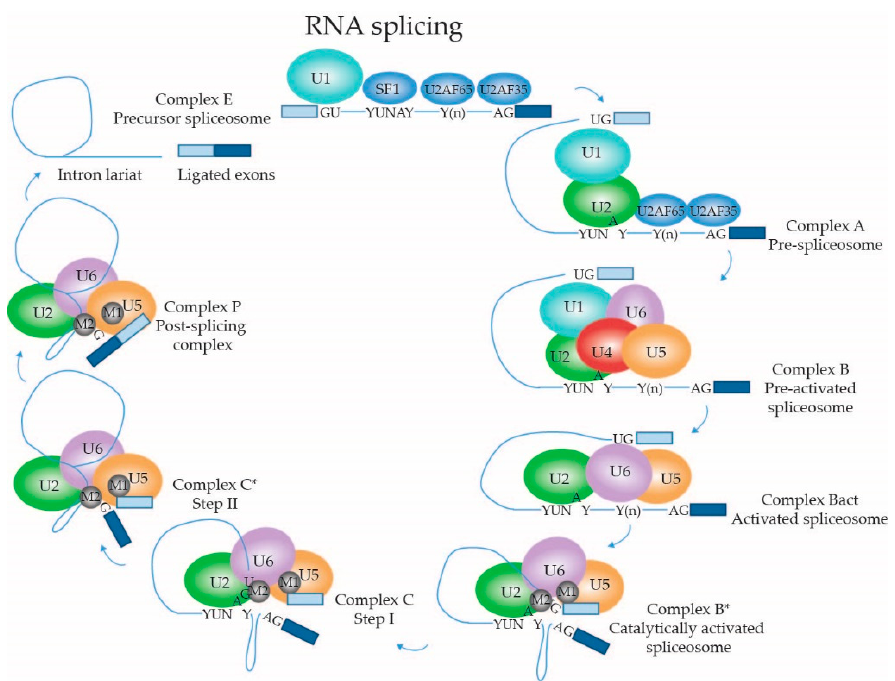
Figure 3. Pre-mRNA splicing reaction performed by the spliceosome. The dynamic composition of the spliceosome, with it different intermediate complexes, is illustrated. Details are given in the main text. Light and dark blue boxes, exons; line, intron; GU, 5 ′ splice site; AG, 3 ′ splice site; YUNAY, branchpoint sequence; Y(n), polypyrimidine tract; M1 and M2, Mg 2+ metal ions at the catalytic site.